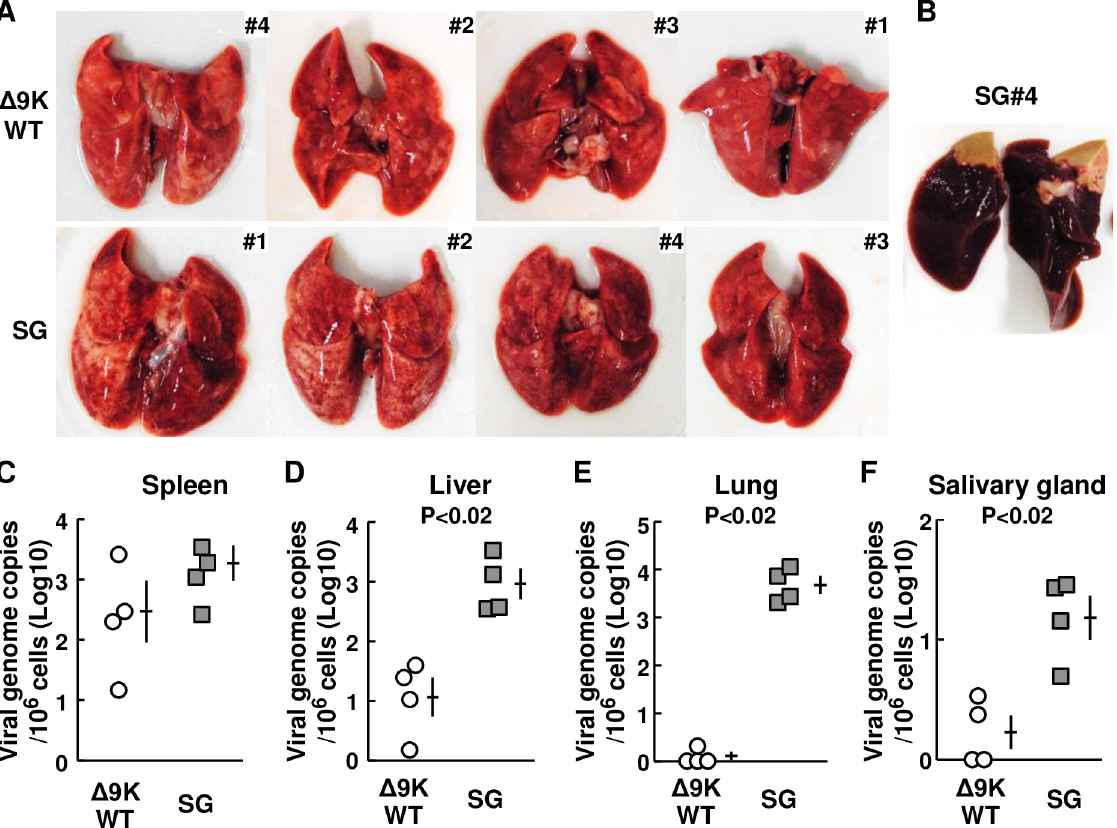
Fig 10. BAC-derived GPCMV strains showed attenuated phenotypes. Pregnant guinea pigs (Hartley) at 4 weeks’ GA were infected s.c. with GPCMV Δ 9K WT or with GPCMV SG (n = 4 each; 3x10 6 IUs/animal) and sacrificed at 6 days p.i. to collect specimens. (A) Images of the lungs obtained from the dams infected with GPCMV Δ 9K WT (upper row) or GPCMV SG (lower row) are shown in the order of abnormalities in appearance from most severe to mildest. (B) An image of the liver with necrotic lesion that was obtained from one of the dams infected with GPCMV SG. (C-F) GPCMV genome copies per 10 6 cells of the spleens (C), livers (D), lungs (E), and salivary glands (F) obtained from the dams infected with GPCMV Δ 9K WT (open circles) or GPCMV SG (squares). Means and SEMs are